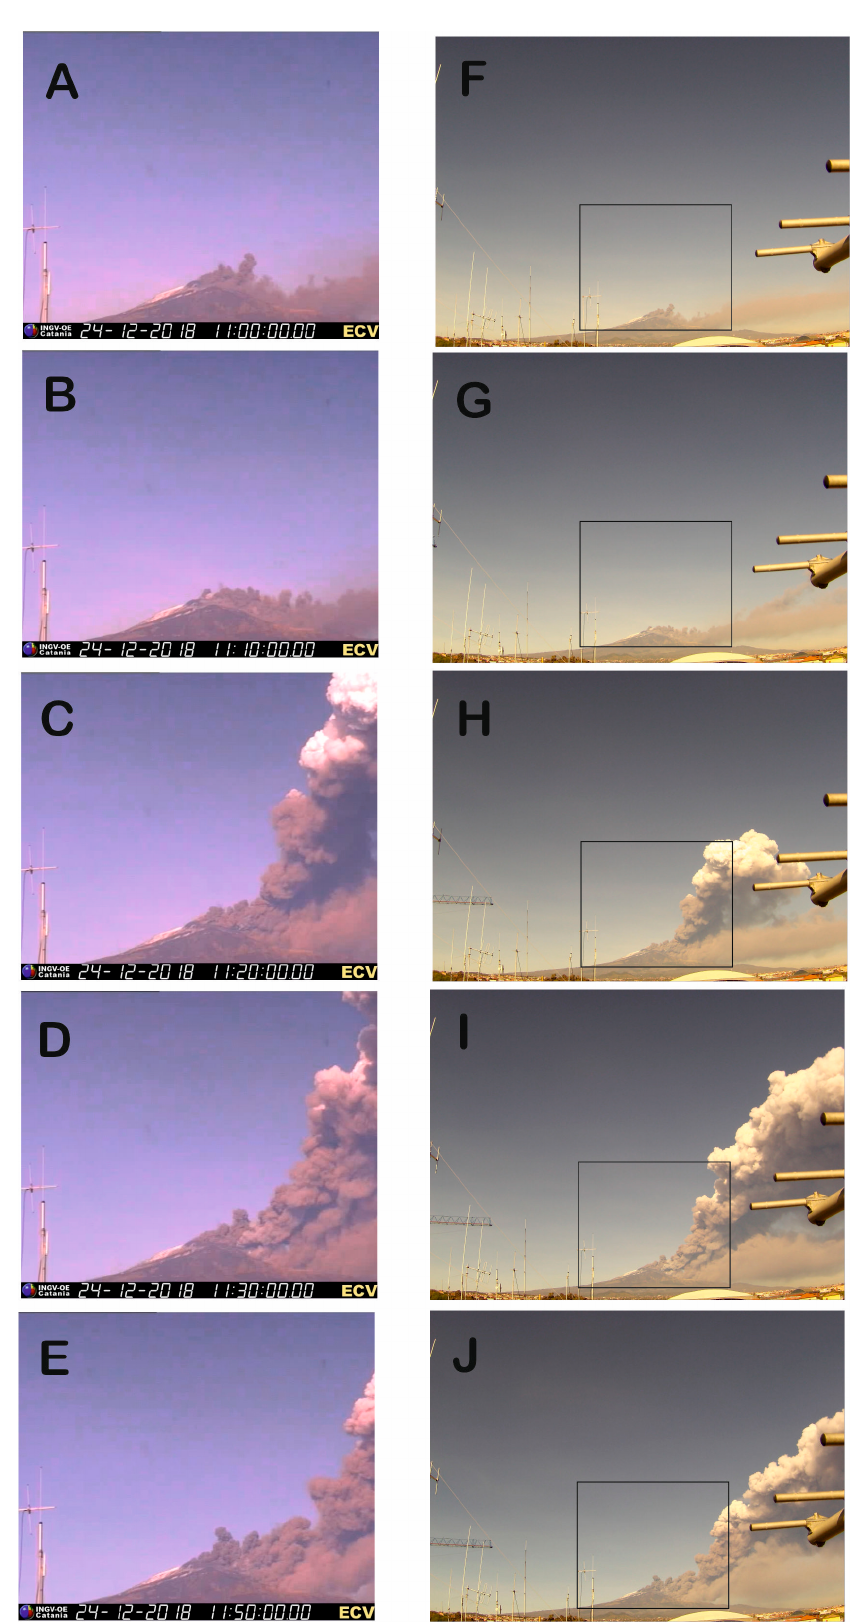
Figure 6. Frames recorded by the ECV camera (left) at 11:00 ( A ), 11:10 ( B ), 11:20 ( C ), 11:30 ( D ), and 11:50 ( E ), and corresponding images recorded by the wide-angle ECVH camera ( F – J ). The black squares in the right frames display the area framed in the corresponding left image, which has the upper boundary at 9 km above sea level [21].